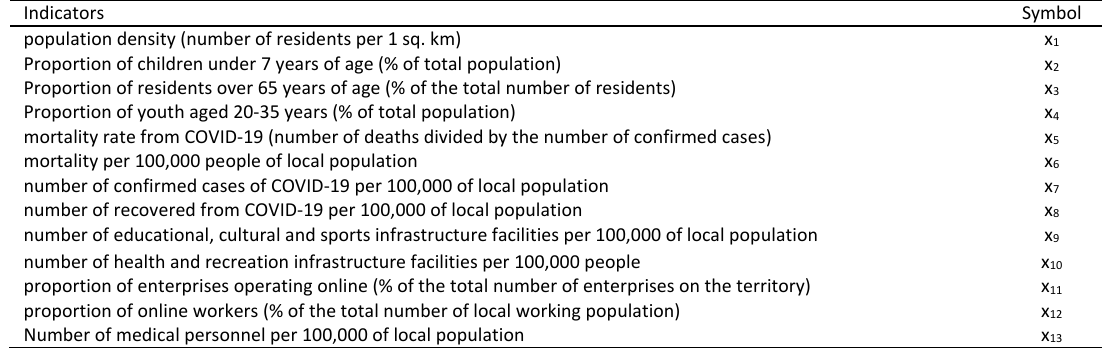
Table 2: System of indicators affecting the resistance level of COVID-19 in rural areas of Sumy region